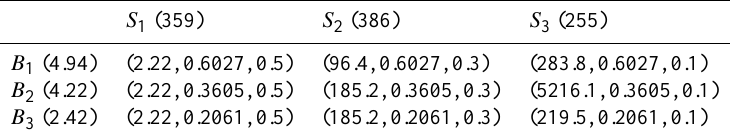
Table 5. Best-fit parameters for model S3B3-ECA by optimizing the simulation outputs to the 77-month red pine litter decomposition (cid:16) (cid:17) K S ,ij ,k + ,µ ij experiment data in Melillo et al. (1989). The parameter vectors are presented in the form , whose units are, respectively, ij, 2 gC, d − 1 , and none. The respiratory coefficients (i.e., γ j ,j = 1 , 2 , 3 as defined in Eq. (31) of the three microbes are, respectively, set to 0.01, 005, and 0.001d − 1 . Numbers in the parentheses following the state variables are their initial values, whose units are gC. In doing the ,i = 1 , 2 , 3 are calibration, we assumed (i) K S , 1 j ,j = 1 , 2 , 3 are same for all three microbes; (ii) K S , 22 = K S , 23 ; (iii) for microbe B j , k + ij, 2 same for all three substrates. By further fixing µ ij to the values in the parentheses, we effectively had a total 12 parameters in the calibration. S 1